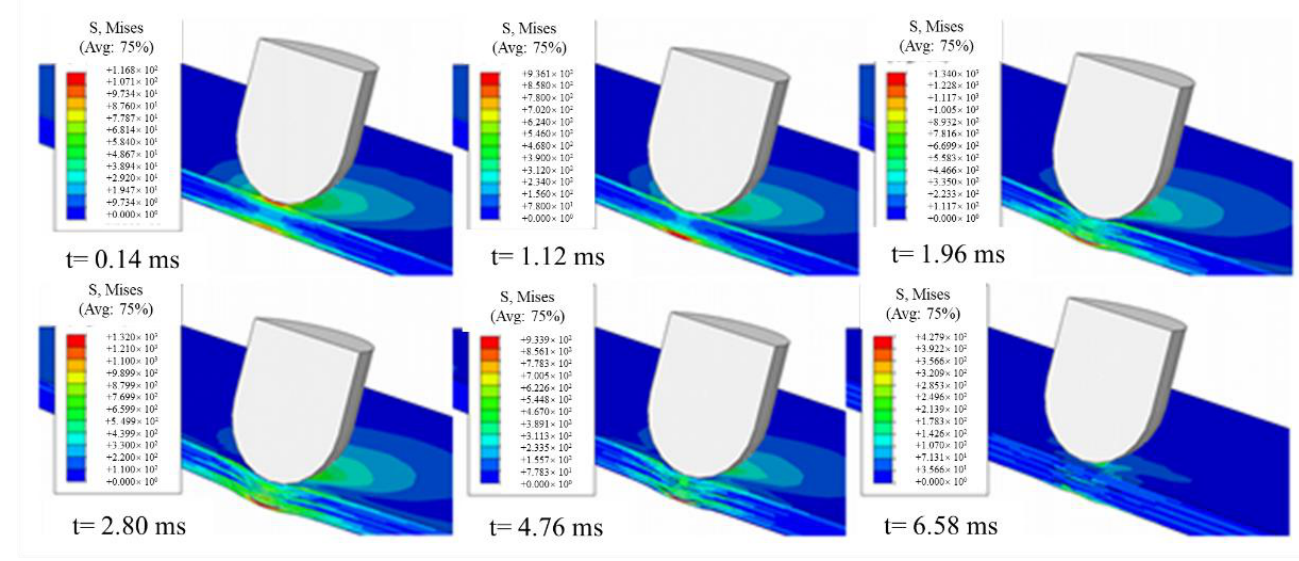
Figure 4. Impact history of CF/BF hybrid composite laminates.